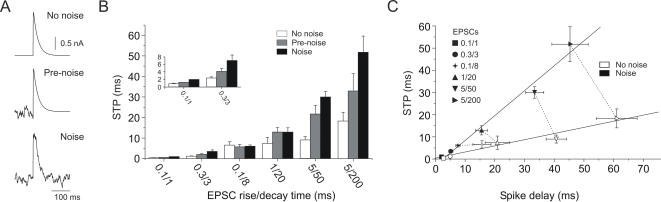
Differences in STP between fast and slow EPSCs increase with added synaptic background noise. A, Synchronized compound EPSC without noise (top), with the presentation of fluctuating currents previous to the compound (middle) and during the compound EPSC (bottom). B, Comparing the effect of noise on STP for different EPSC shapes. Inset shows results for EPSPs 0.1/1 and 0.3/3 drawn on a larger scale. The addition of background noise had similar effects on fast and slow EPSCs, with the exception of EPSPs with τrise/τdecay 0.1/8 ms, which produced similar STPs under all three conditions (ANOVA, p>0.05) and τrise/τdecay 1/20 ms, which showed decreased STP under noise conditions (p<0.05), but no difference in STP between the noise and pre-noise condition (p>0.05). For EPSCs with slow dynamics (τrise/τdecay 5/50 and 5/200 ms), STP was reduced in the pre-noise condition by 82.5±4.3% and by 182.7±8.5% in the noise condition. For fast EPSCs, STP was reduced by 39.5±1.7% in the pre-noise condition and by 127.9±3.2% in the noise paradigm (ANOVA = p<0.05). C, Spike delay relative to stimulus onset and spike time precision were linearly related. The addition of simulated synaptic background noise increased the slope of the STP vs. delay function (linear regression). Same data as in B, each symbol corresponds to the same EPSCs as B. Each connected pair of symbols corresponds to the same compound EPSC value (mean±s.e.m.; n = 10 cells).